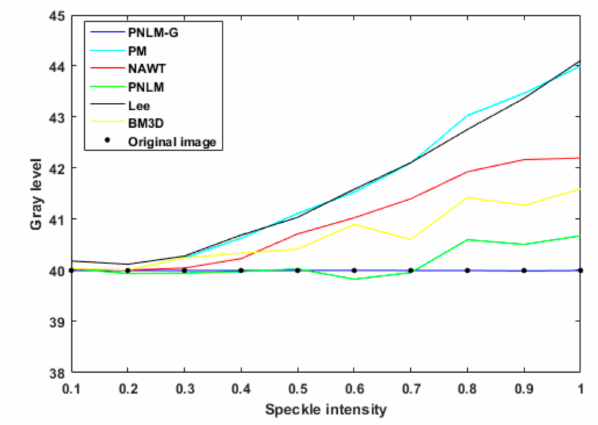
Figure 8. Comparison of the ability of the six algorithms to restore the gray value of an